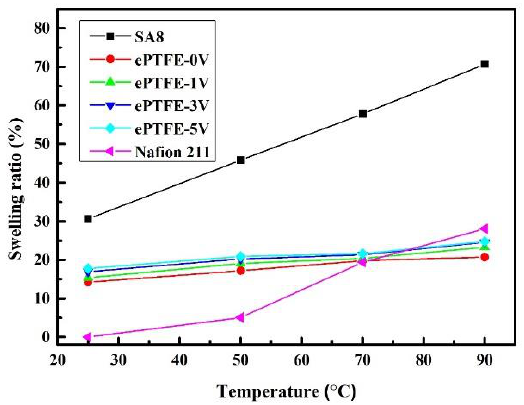
Figure 10. Swelling ratios of ePTFE membranes at various temperatures.